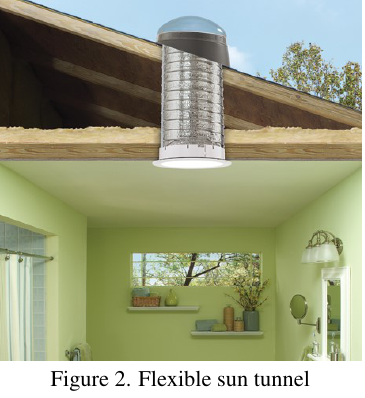
Figure 2. Flexible sun